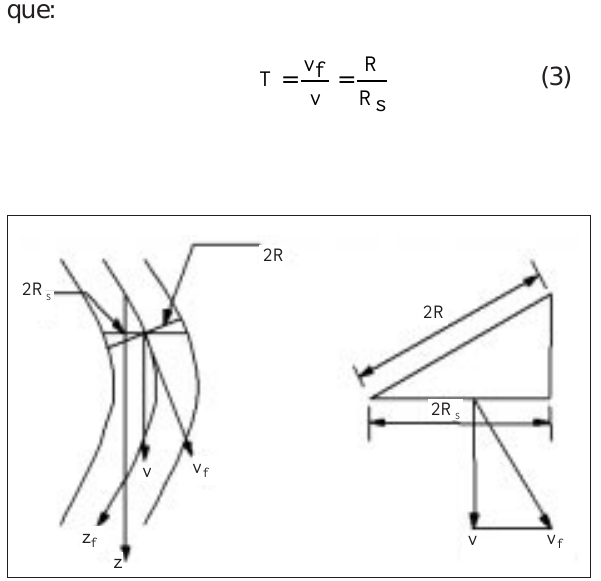
Figura 1. A tortuosidade e os triângulos semelhantes formados pelos raios e as velocidades. A velocidade v é referenciada à trajetória z do movimento e a velocidade v é referenciada à f trajetória “tortuosa” do